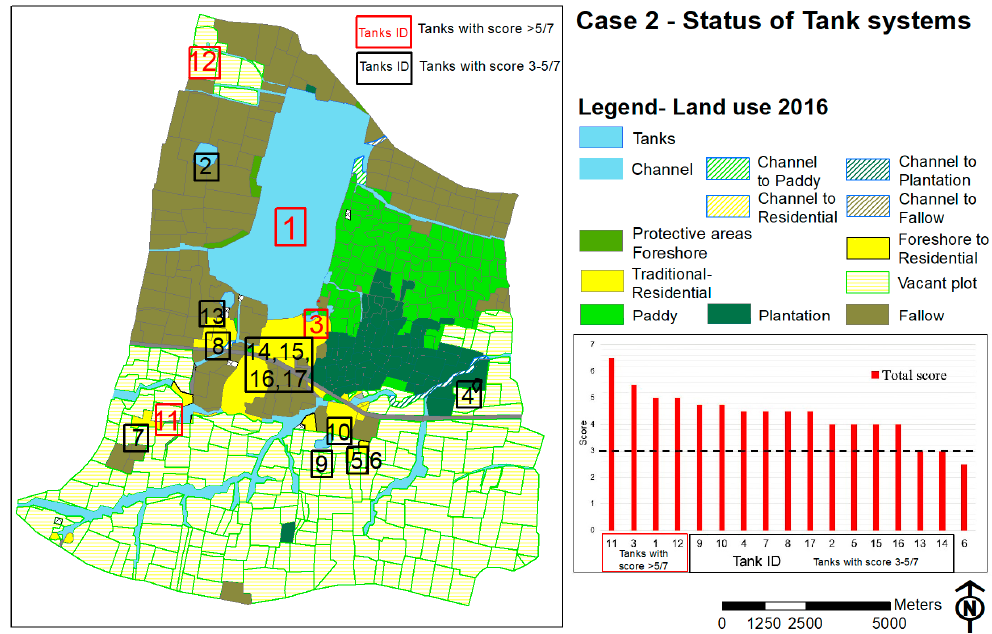
Figure 14. Relationship between change in agricultural land use and the status of the tank systems in case 2.